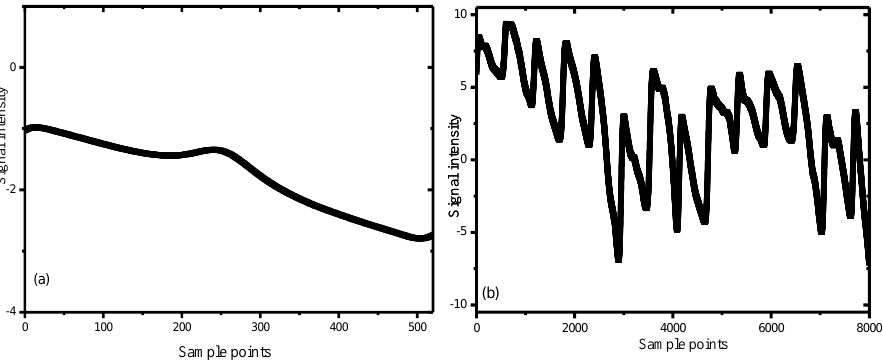
Figure 2. Spectral signals. ( a ) Signal of the reference optical path, ( b ) Signal of the detection optical path (multiple periodic signals).